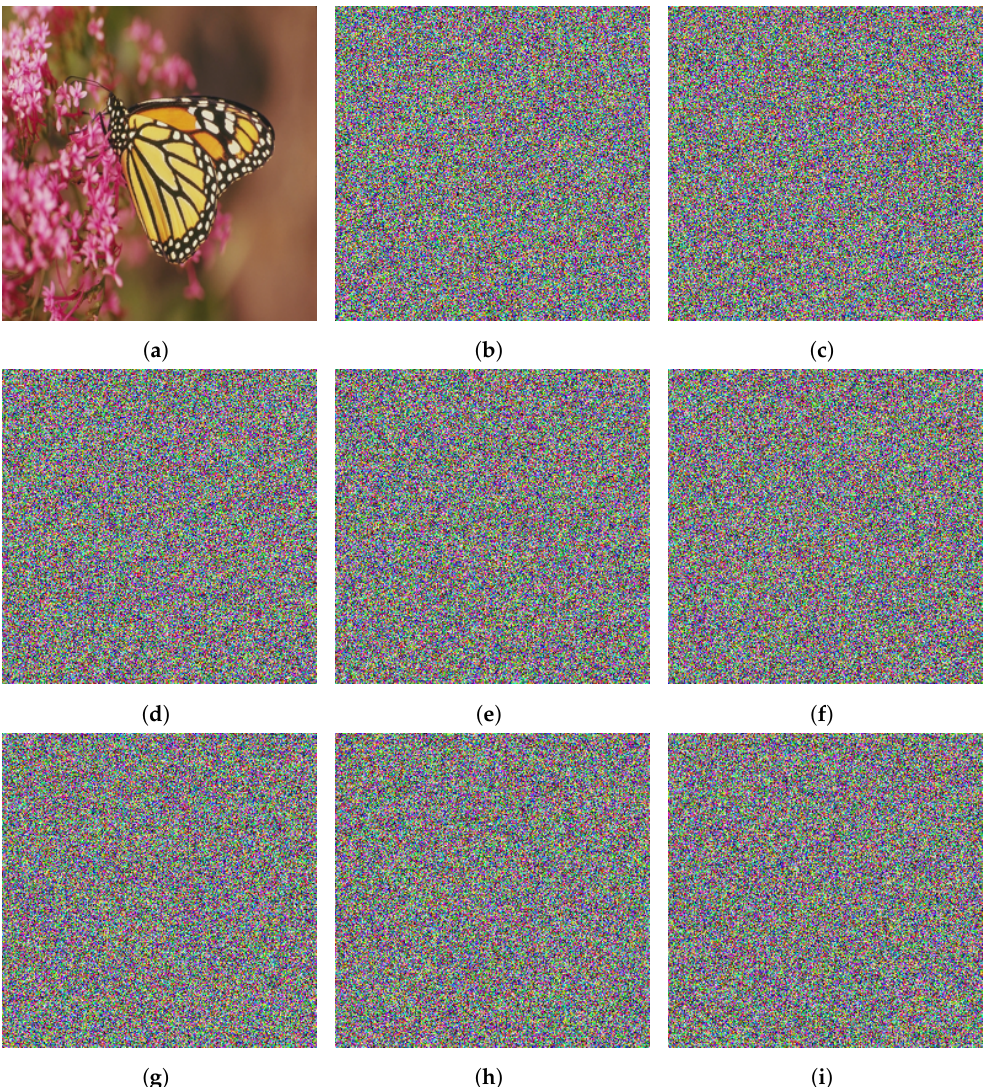
Figure 13. Outcomes of decryption process for the encrypted image EImg01-1 using different values of key parameters. ( a ) Correct key. ( b ) Correct key except for N = 263. ( c ) Correct key except for S = 520. ( d ) Correct key except for β = π /3. ( e ) Correct key except for θ 0 = π /2. ( f ) Correct key except for θ 1 = π /2. ( g ) Correct key except for θ 2 = π /6. ( h ) Correct key except changing the first bit of T from 0 to 1. ( i ) Correct key except removing the last bit of T